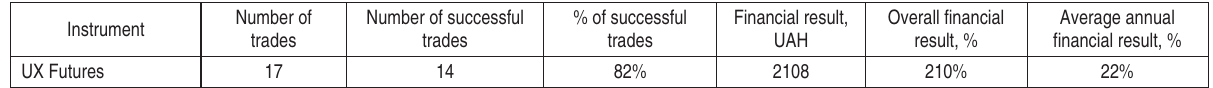
Table 5. Trading simulation results for the month-of-the-year effect (UX futures)